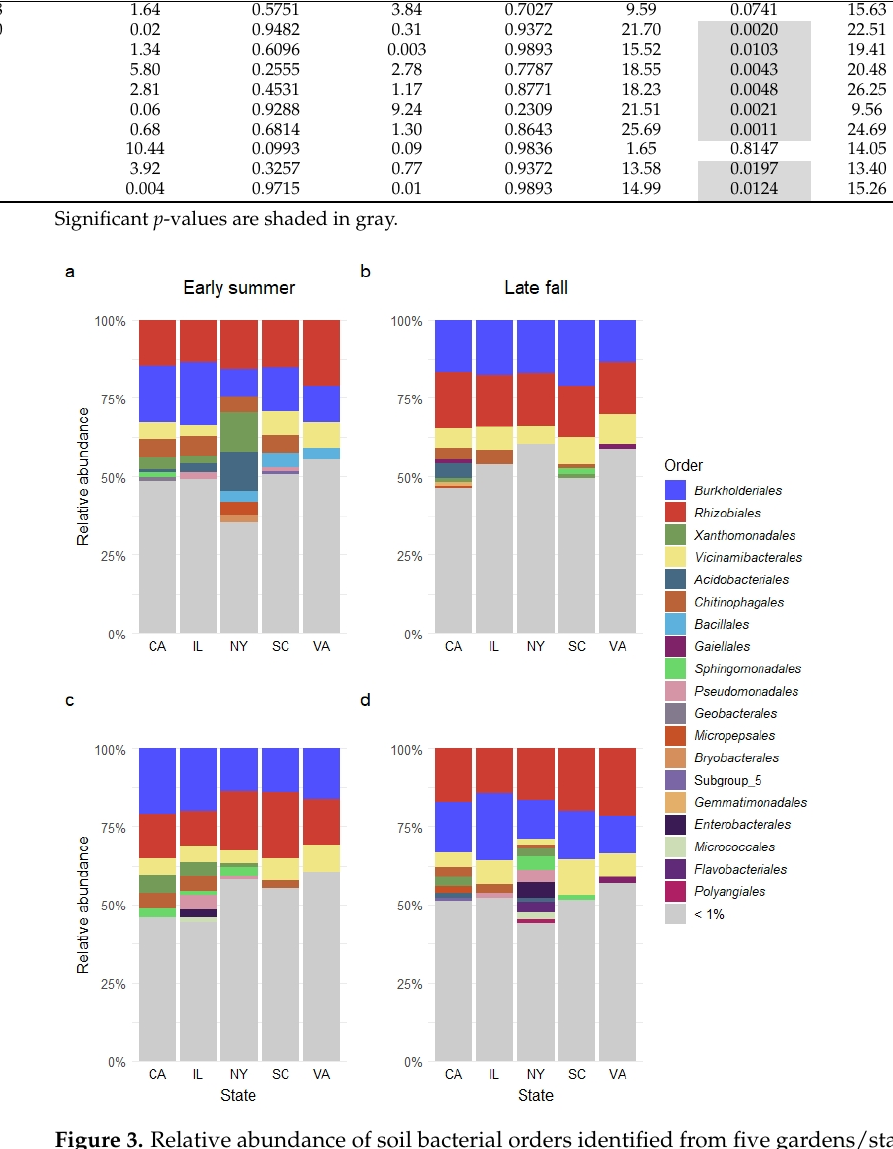
Figure 3. Relative abundance of soil bacterial orders identified from five gardens/states: California (CA), Illinois (IL), New York (NY), South Carolina (SC), and Virginia (VA) in early summer ( a , c ) and late fall ( b , d ) of 2017 ( a , b ) and 2018 ( c , d ). Bacterial orders with relative abundance less than 1% were grouped together and indicated by gray color.